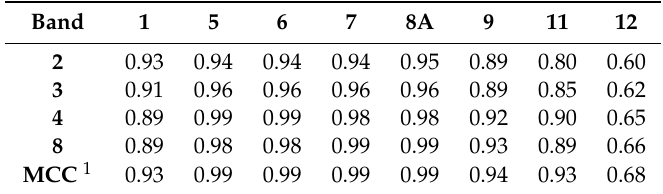
Table 4. The linear correlation coe ffi cients of Sentinel-2A MS10 bands with other bands.